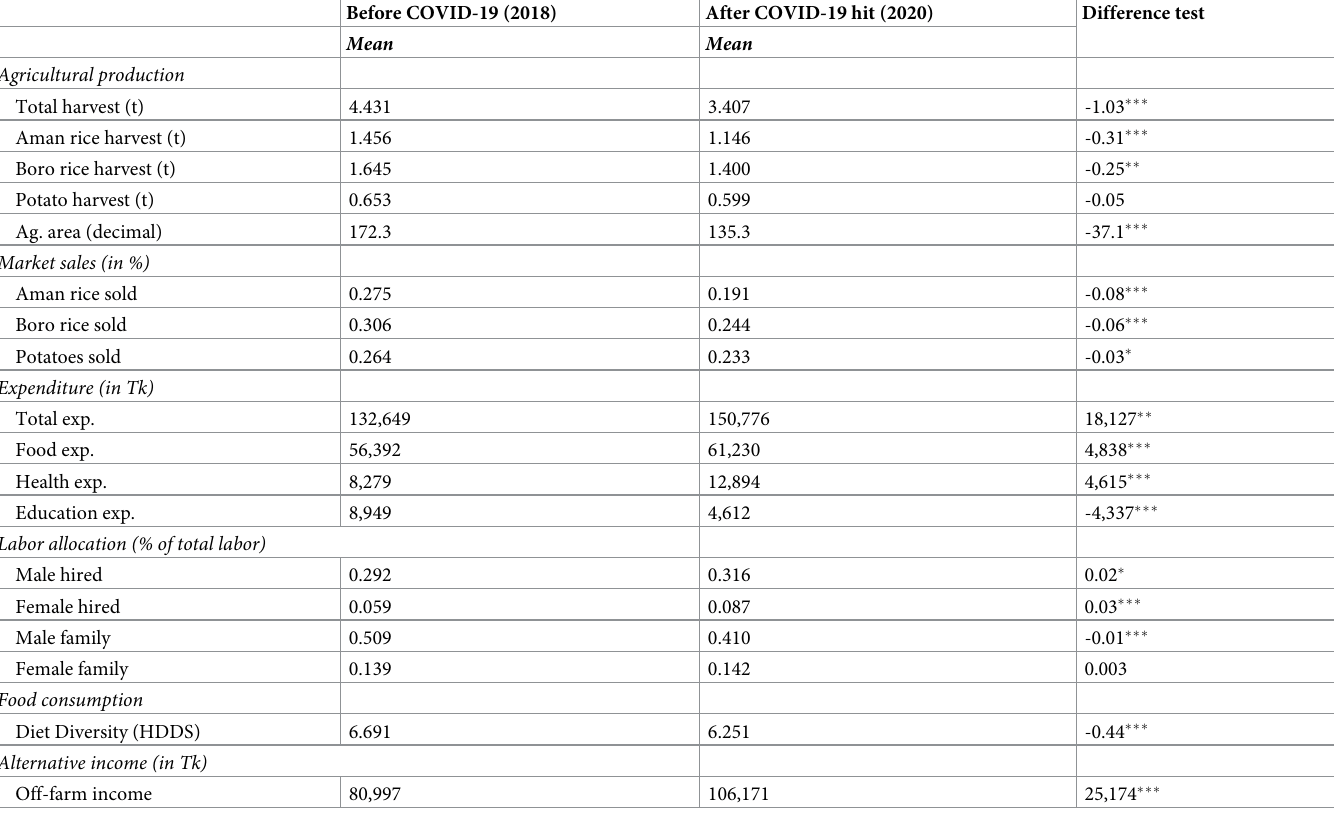
Table 2. Descriptive statistics of outcome